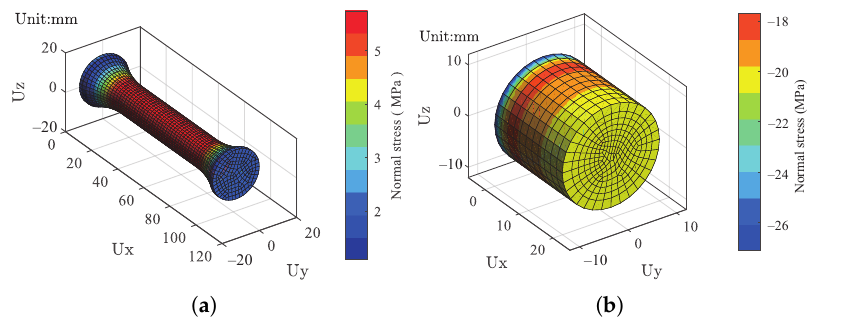
Figure 18. The stress distribution results calculated by the finite element model at − 40 ◦ C. ( a ) Tension, and ( b ) compression.